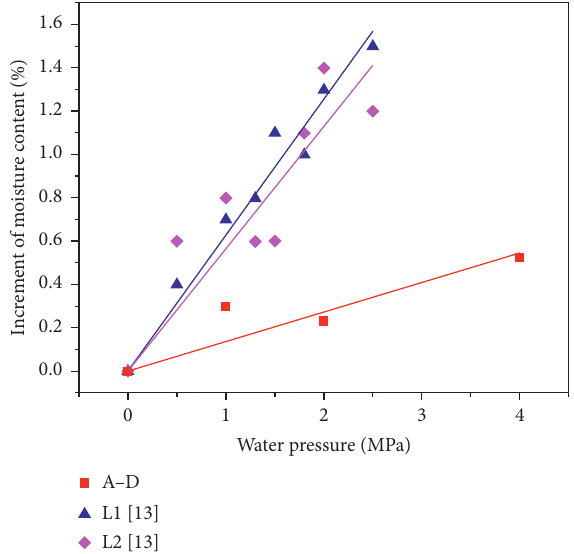
Figure 7: Increment of moisture content of specimens under different water pressure.